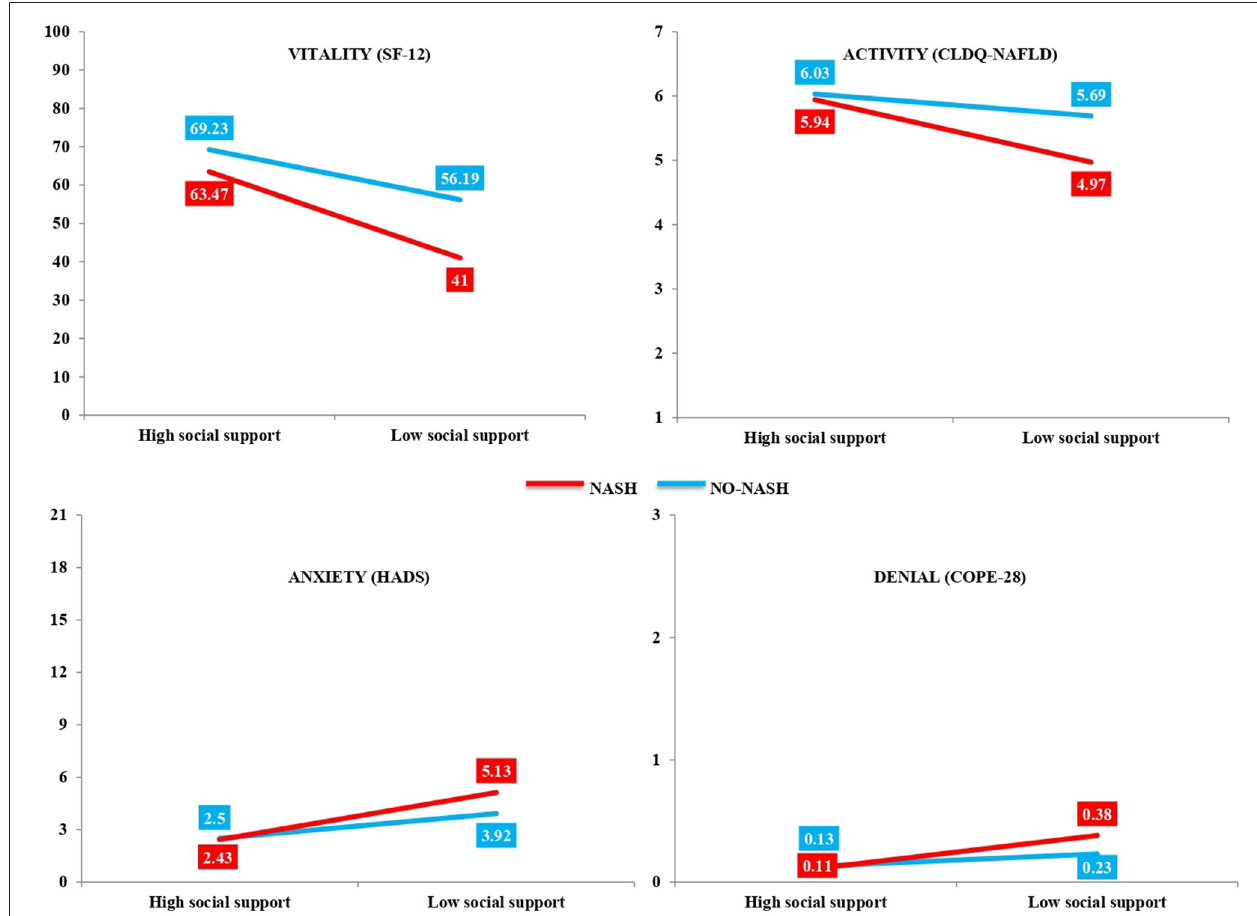
FIGURE 2 | Interactive effects of non-alcoholic steatohepatitis (NASH; absence or presence) and level of social support (high or low) factors. Analysis of the influence of NASH and social support on the quality of life, mental health, and coping strategies of non-alcoholic fatty liver disease (NAFLD) patients showing interactive effects in vitality ( p = 0.05), activity ( p = 0.005), anxiety ( p = 0.04), and denial ( p = 0.04).